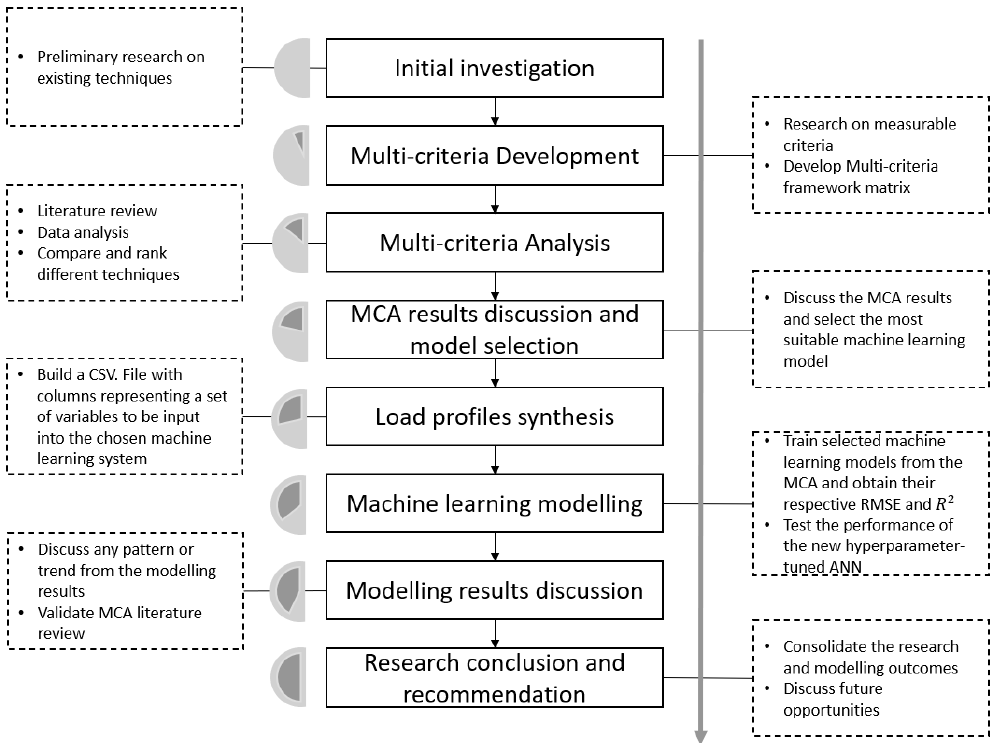
Figure 3. Research